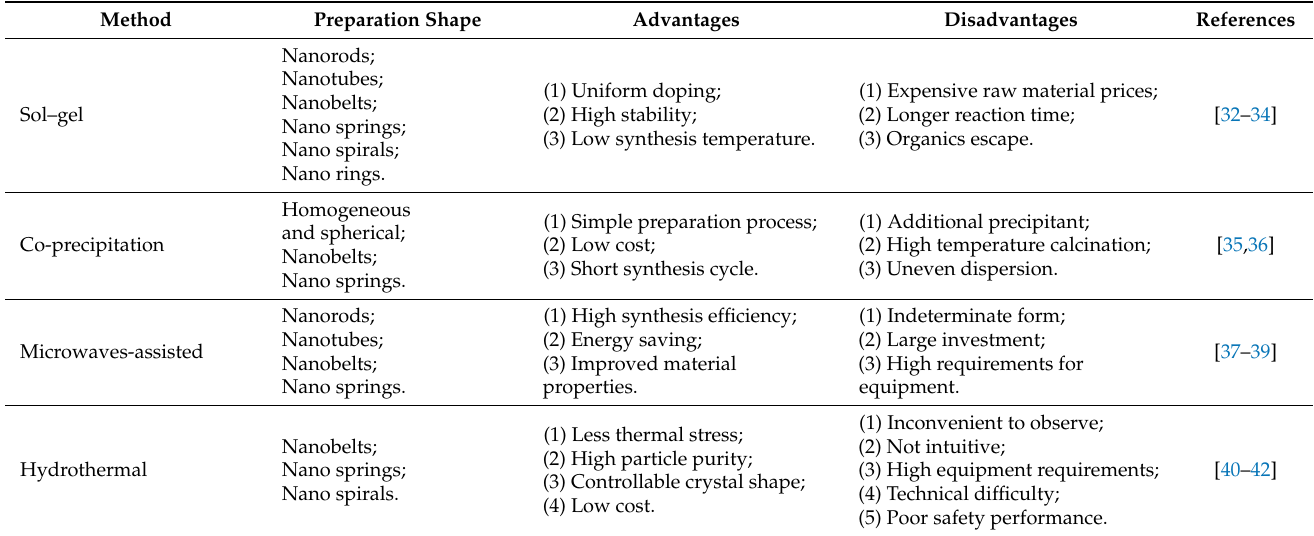
Table 1. Advantages and disadvantages of different antibacterial synthesis